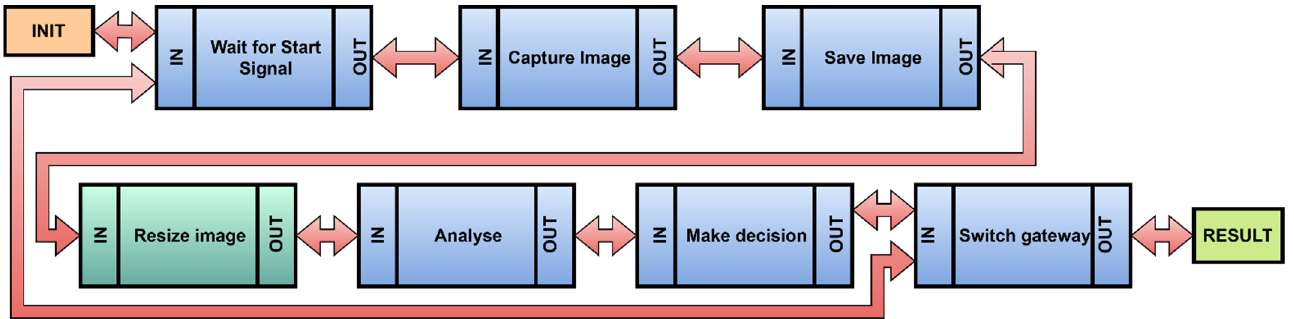
Figure 20. A workflow of the IIoT device.